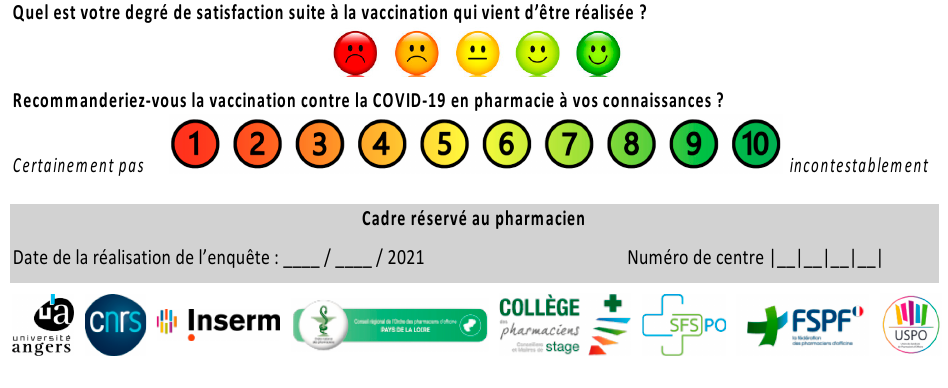
Figure A1. French PharmaCoVax